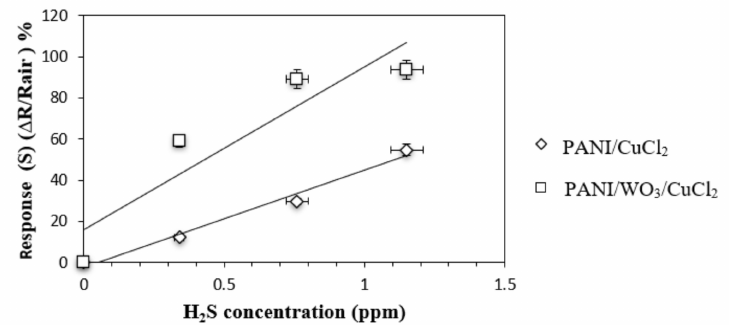
Figure 23. Calibration curve for sensor response with increasing H 2 S gas